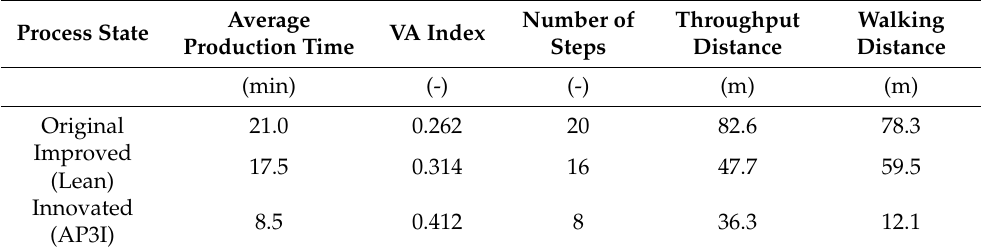
Table 8. Comparison of improvement by classical indicators—packing